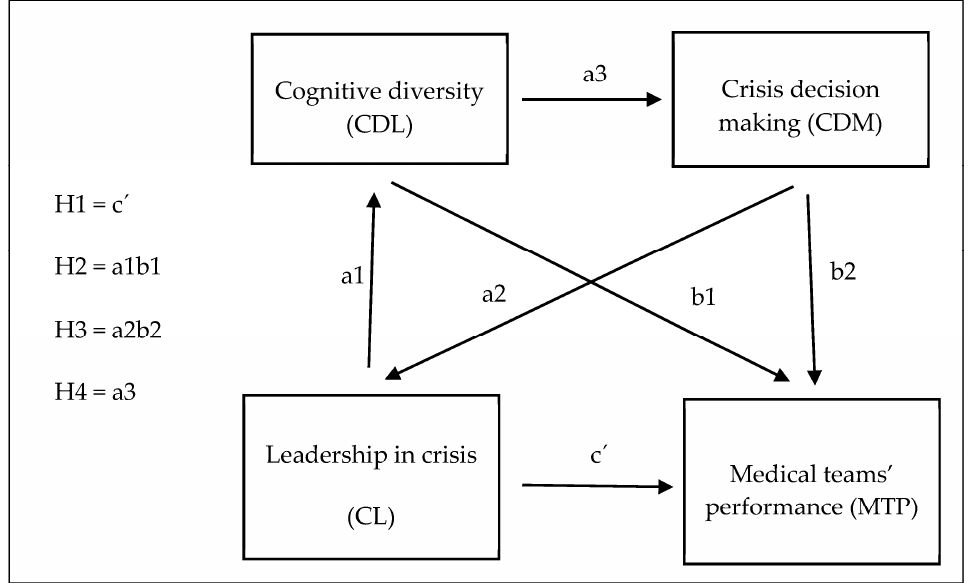
Figure 1. The mediation model and the 4 tested hypotheses. Source: own processing.